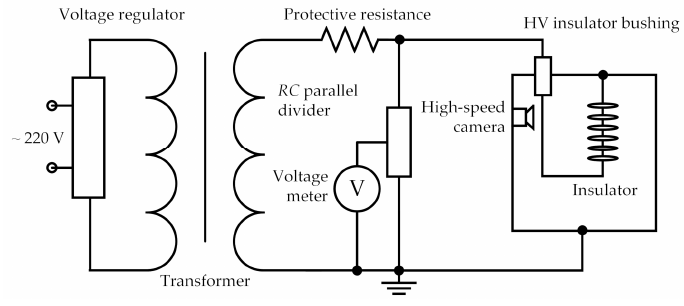
Figure 11. The schematic of the dry band formation and arcing experiment system.